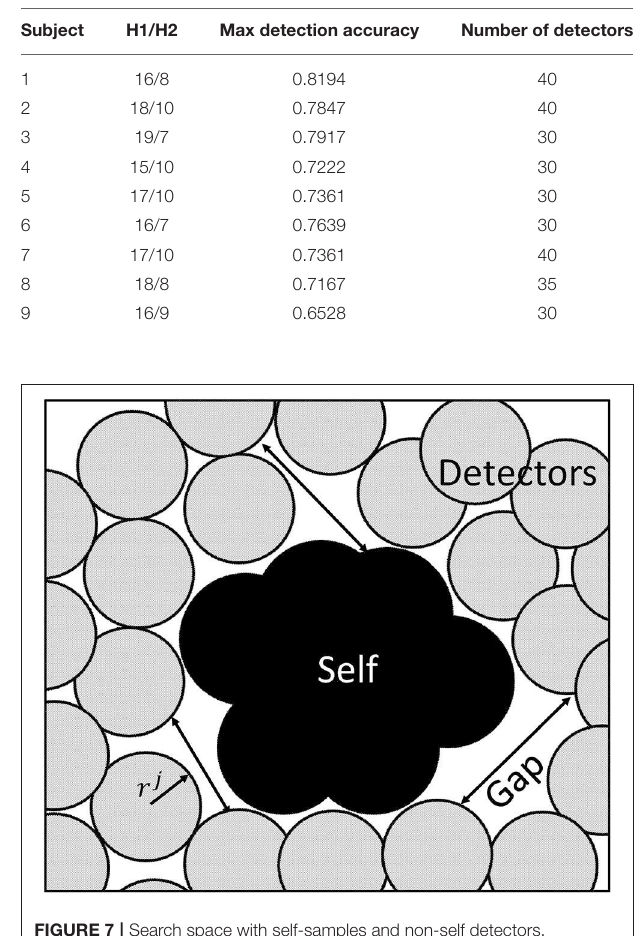
TABLE 2 | Detection accuracy for subject 1. TABLE 3 | Maximum detection accuracy for all nine subjects.